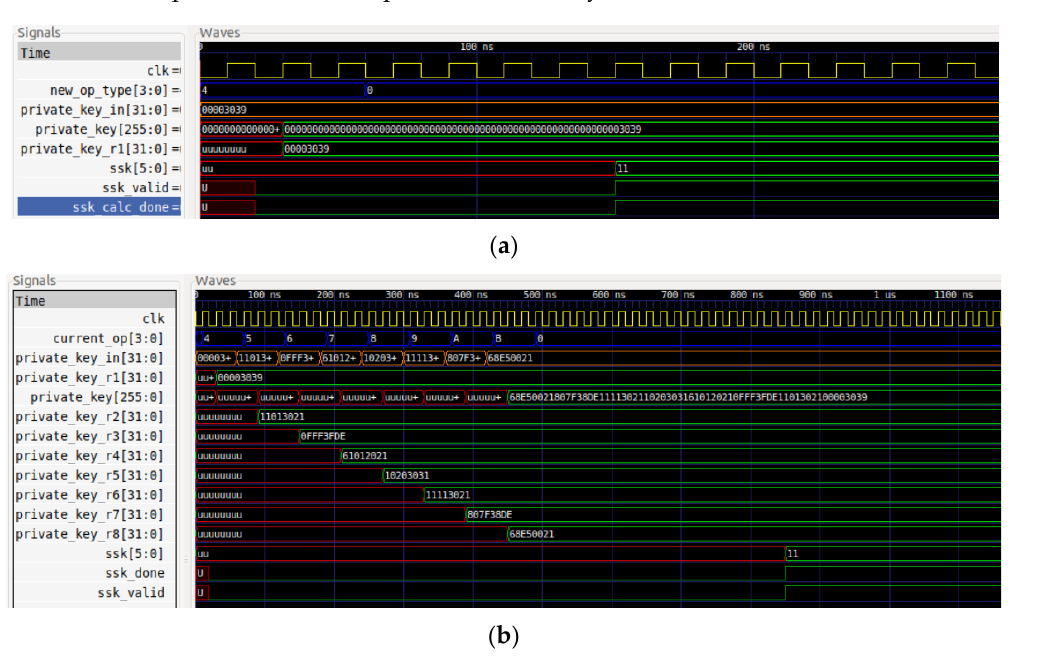
Figure 7. Insertion and modular inverse calculation of the symmetric key with: ( a ) 32-bit; and ( b ) 256-bit size.